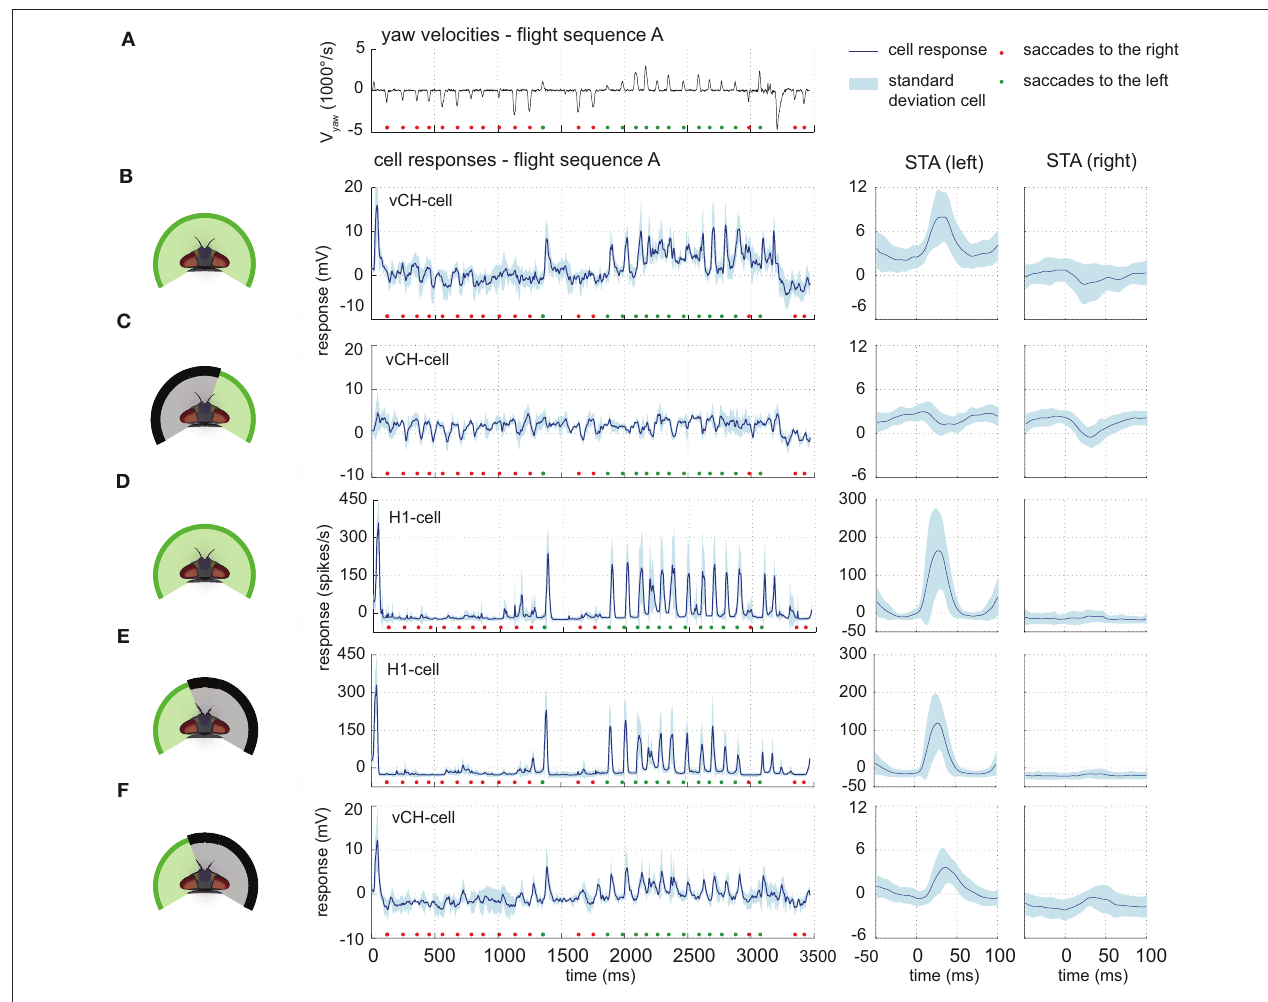
response average around saccades in a given direction (specified in brackets) plotted against time. Time 0 represents the time of maximal yaw velocity during the saccades. The middle section of the plotted STA relates to the saccades, whereas the outer parts relate predominantly to translatory phases during the intersaccadic intervals. (C) Responses and STAs of the right vCH-cell to flight sequence A. The stimulus is limited to the right part of the visual field. (D,e) Responses and STAs of the left H1-cell to flight sequence A. (e) The stimulus is limited to the left part of the visual field. (F) Responses and STA of the right vCH-cell to flight sequence A during stimulation of the left visual